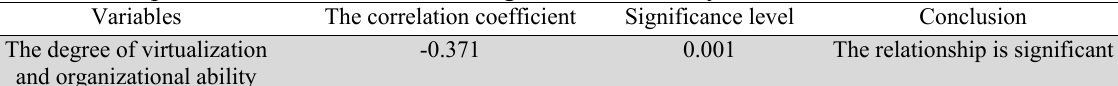
The relationship between virtualization and organizational